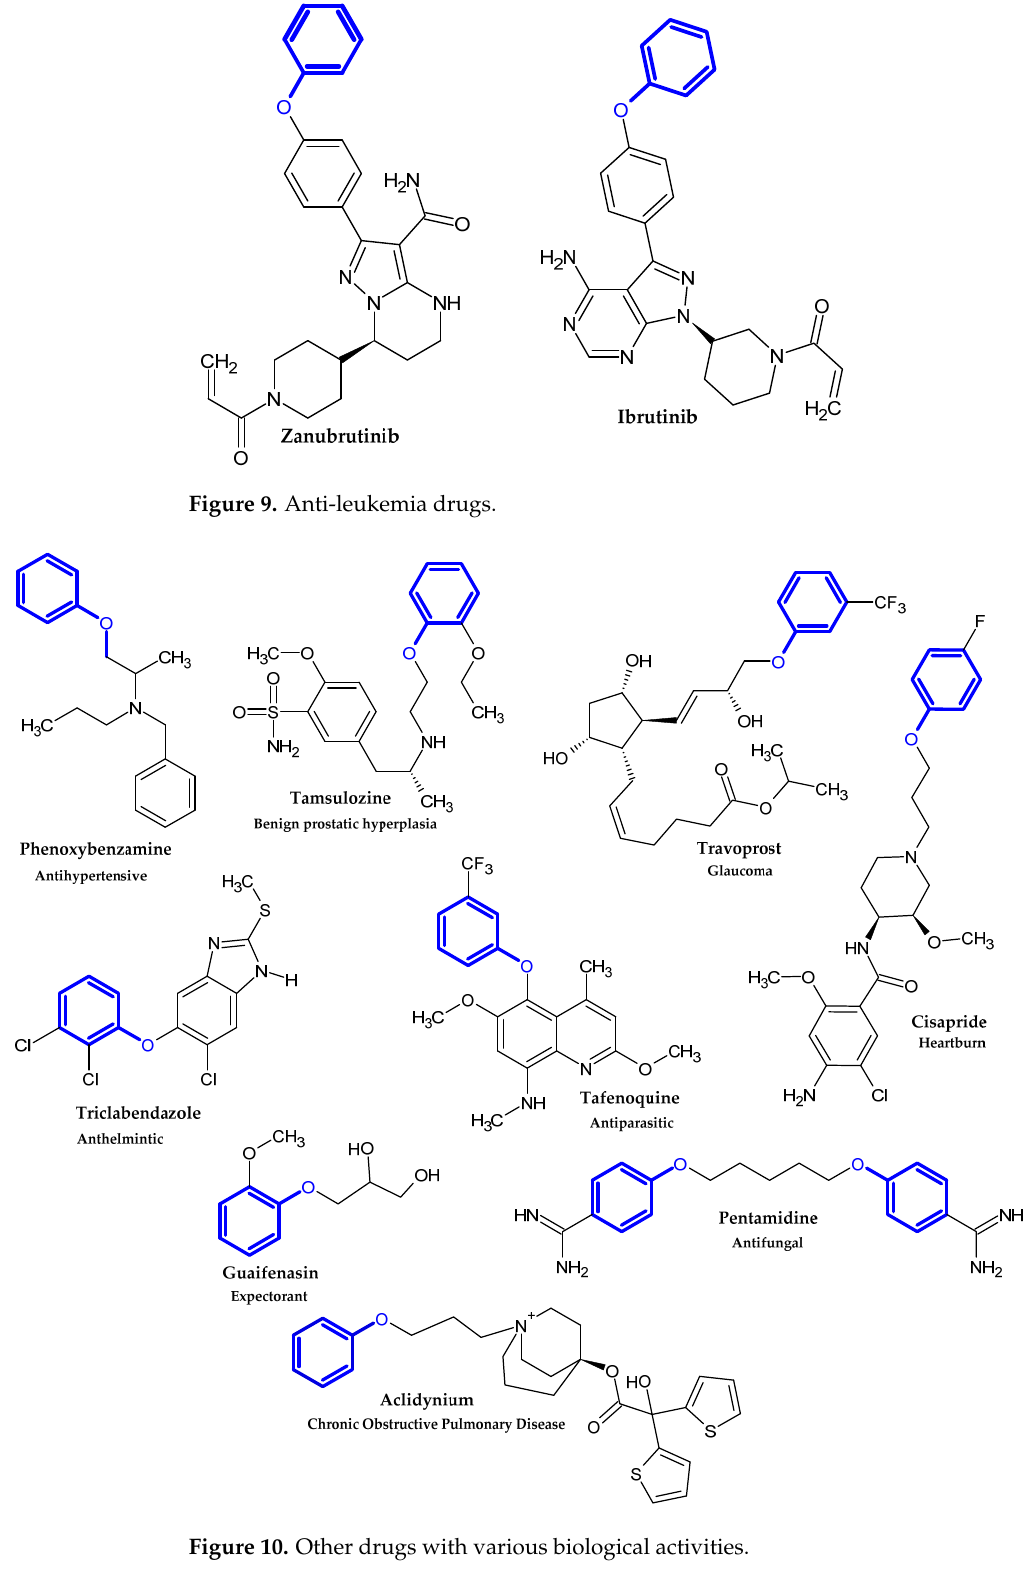
Figure 10. Other drugs with various biological activities.